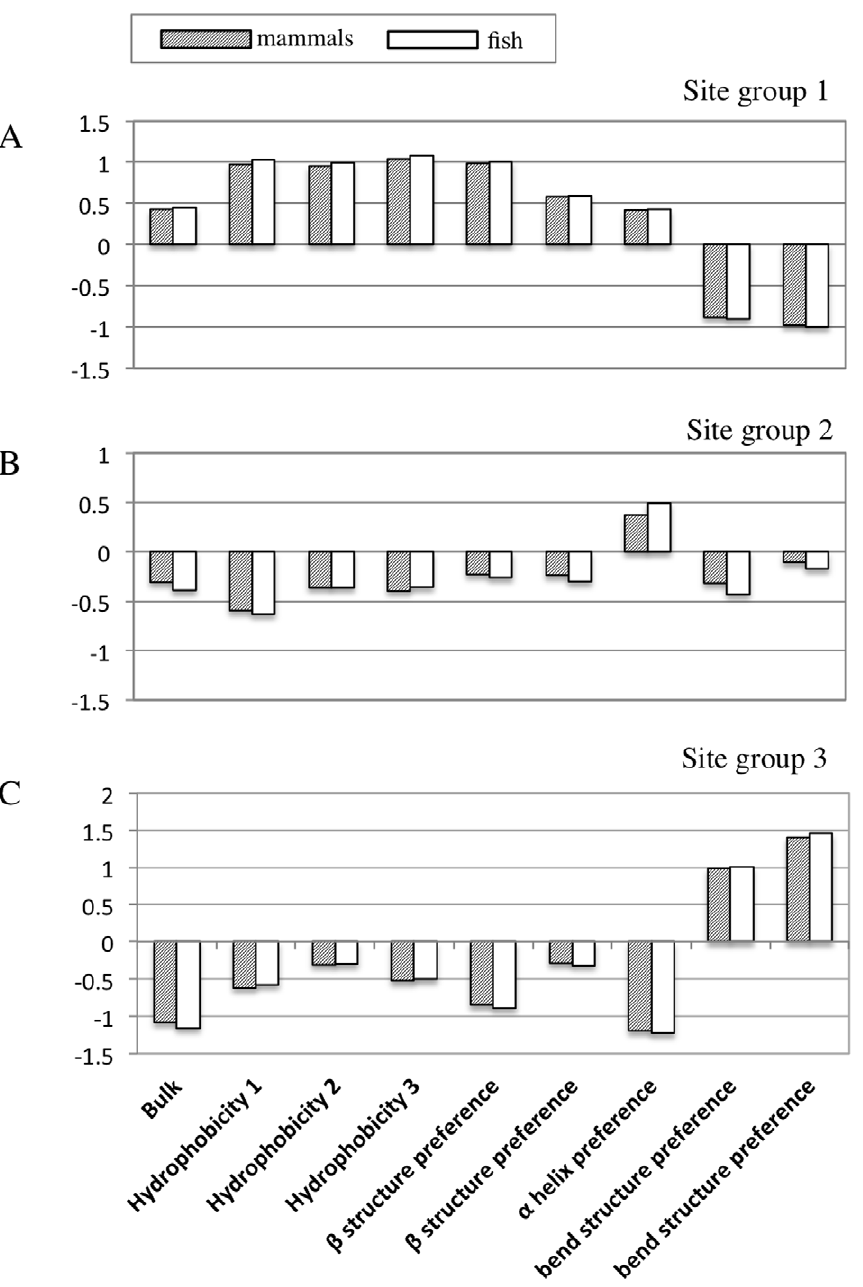
Figure 3. Physiochemical centroids for three groups of sites resolved by K-means clustering. Panel ( A ) shows results for the largest group of sites (1750 for mammals and 1607 for fish). The intermediate group ( B ) was compromised of 1025 sites for mammals and 999 sites for fish. The smallest group ( C ) was compromised of 805 sites for mammals and 764 sites for fish. The physiochemical properties of each of these groups were very similar for mammals and